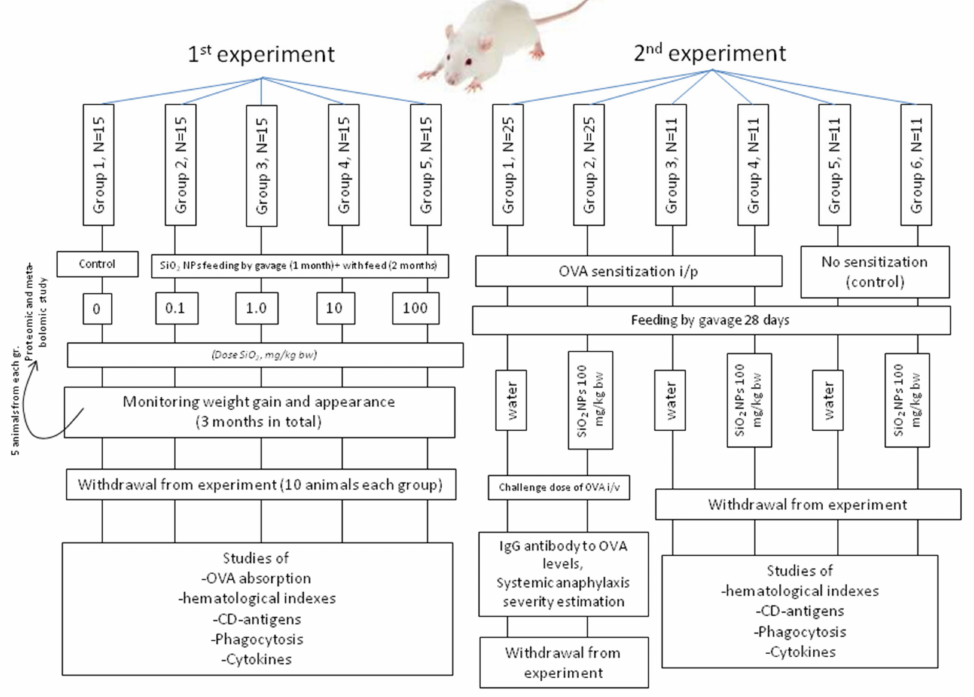
Figure 1. The scheme of the 1st and the 2nd experiments’